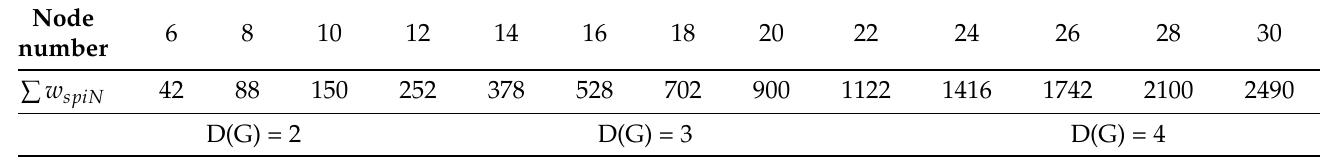
Table 14. Total values of the coefficients of w spi for the third-degree nodes.